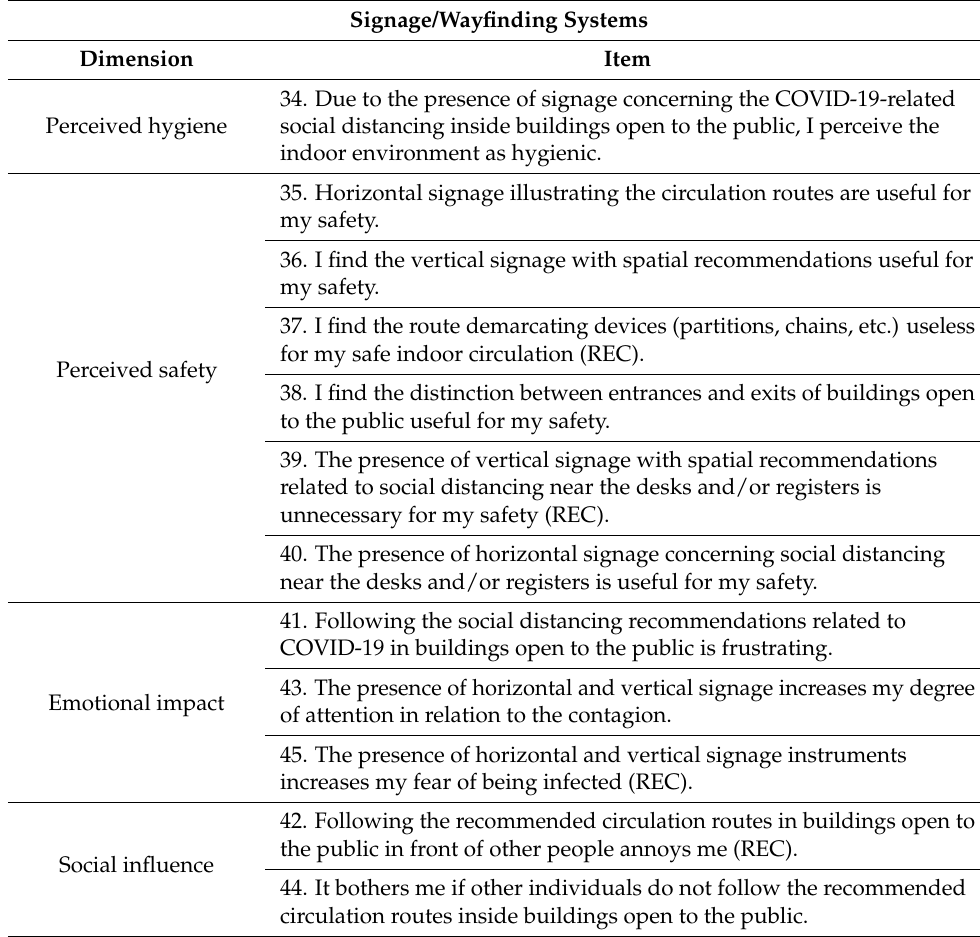
Table 4. Items examined for the signage/wayfinding systems in the online survey and related dimensions. Own processing.